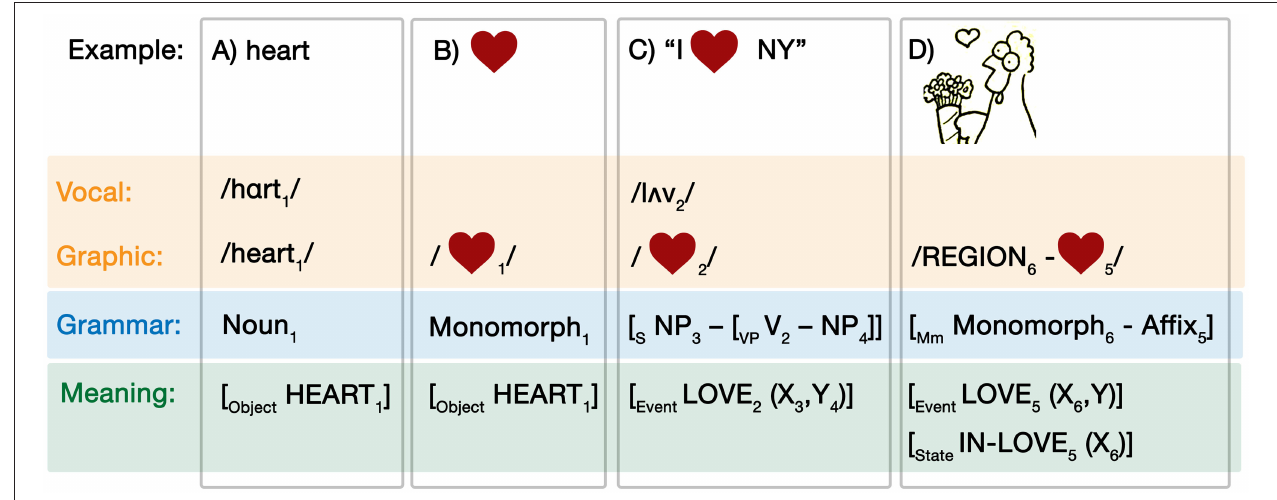
FIGURE 3 | Lexical entries for (A) the word “heart,” (B) the heart shape, (C) a multimodal construction using the heart shape, and (D) the heart shape as a visual